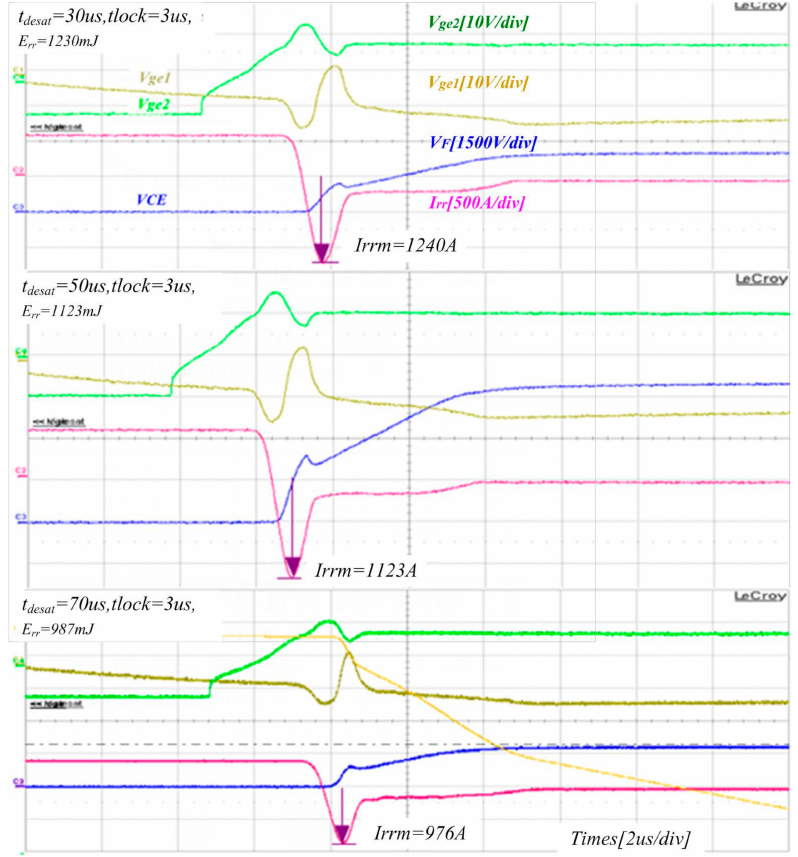
Figure 11. Waveforms of diode reverse recovery under different desaturation pulse